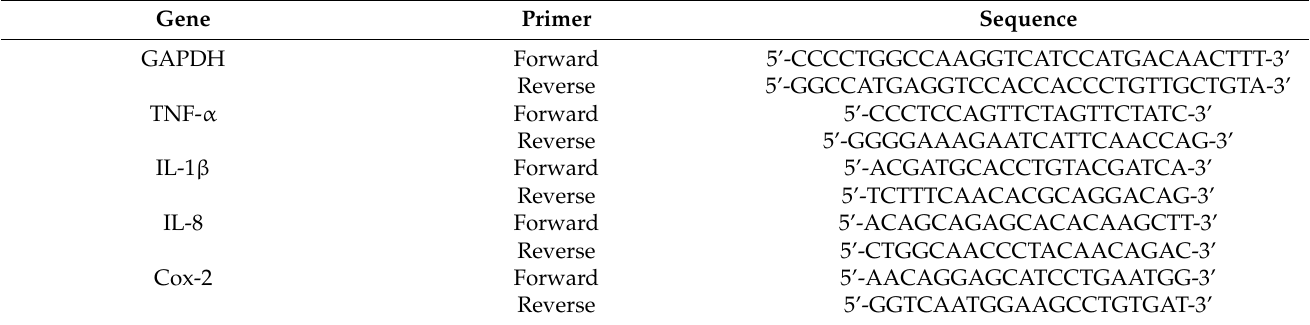
Table 1. Sequence of the primers used in